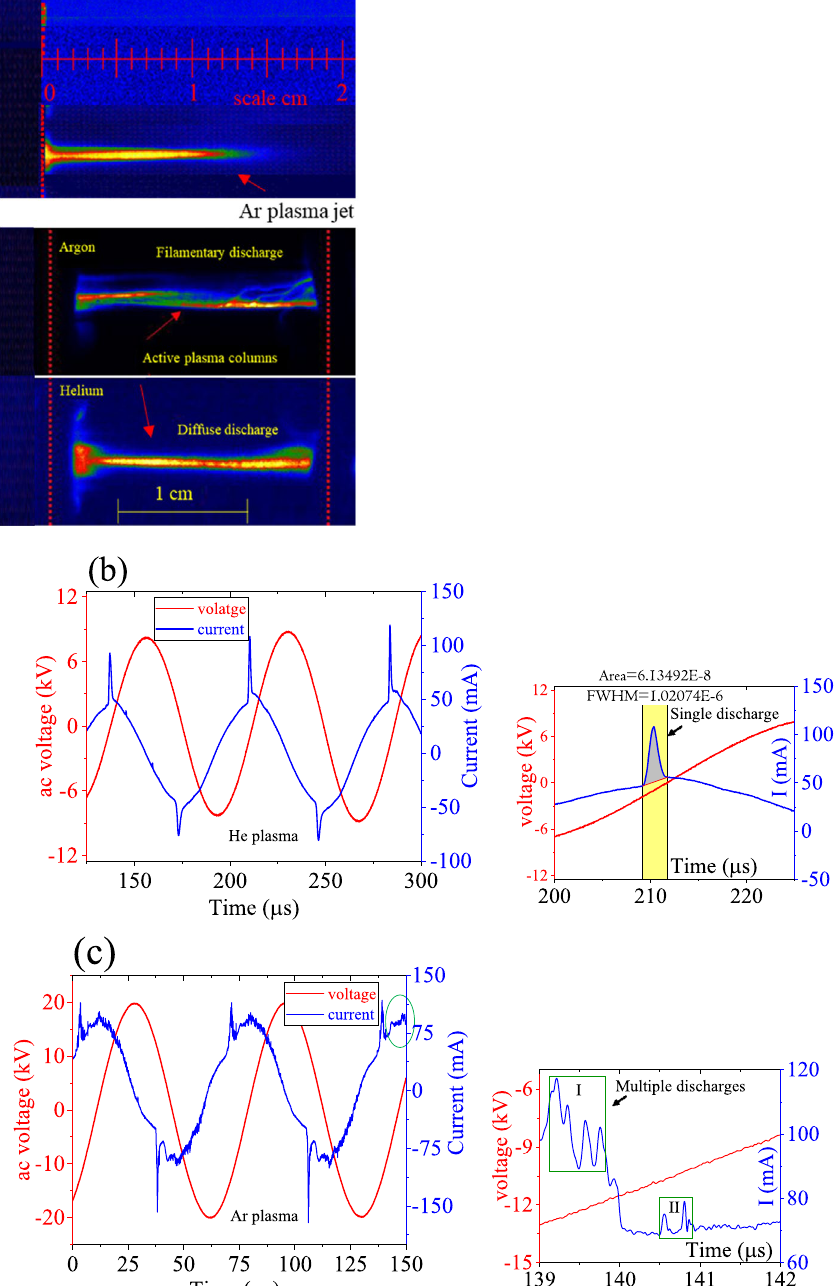
Figure 2. iCCD optical images discharge jets & active plasma columns ( a ), and waveforms of the current– voltage signals ( b ) of argon and helium plasmas generated at 10 lit. min -1 in the tubular geometry in the normal mode operation. The enclosed multiple current peaks in the green circle signposts filamentary behaviour of argon discharge. The insets in ( b ) and ( c ) are enlarged portions, representing the single and multiple discharges of helium and argon respectively. The area under the curve in the inset of ( b ) represents the total amount of charge in the single discharge per half cycle of the ac